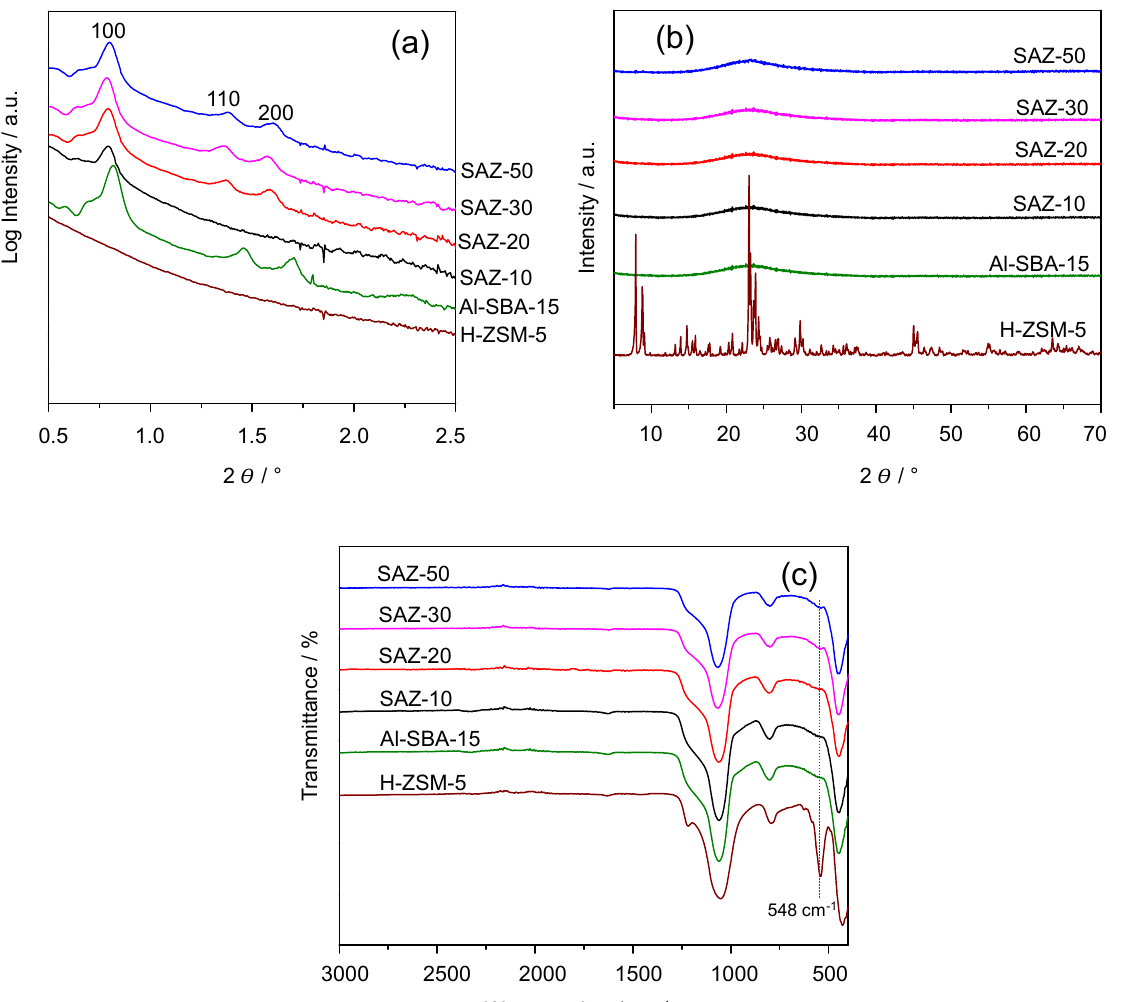
Figure 1. ( a ) Small angle X-ray Scattering (SAXS); ( b ) X-ray diffraction (XRD)